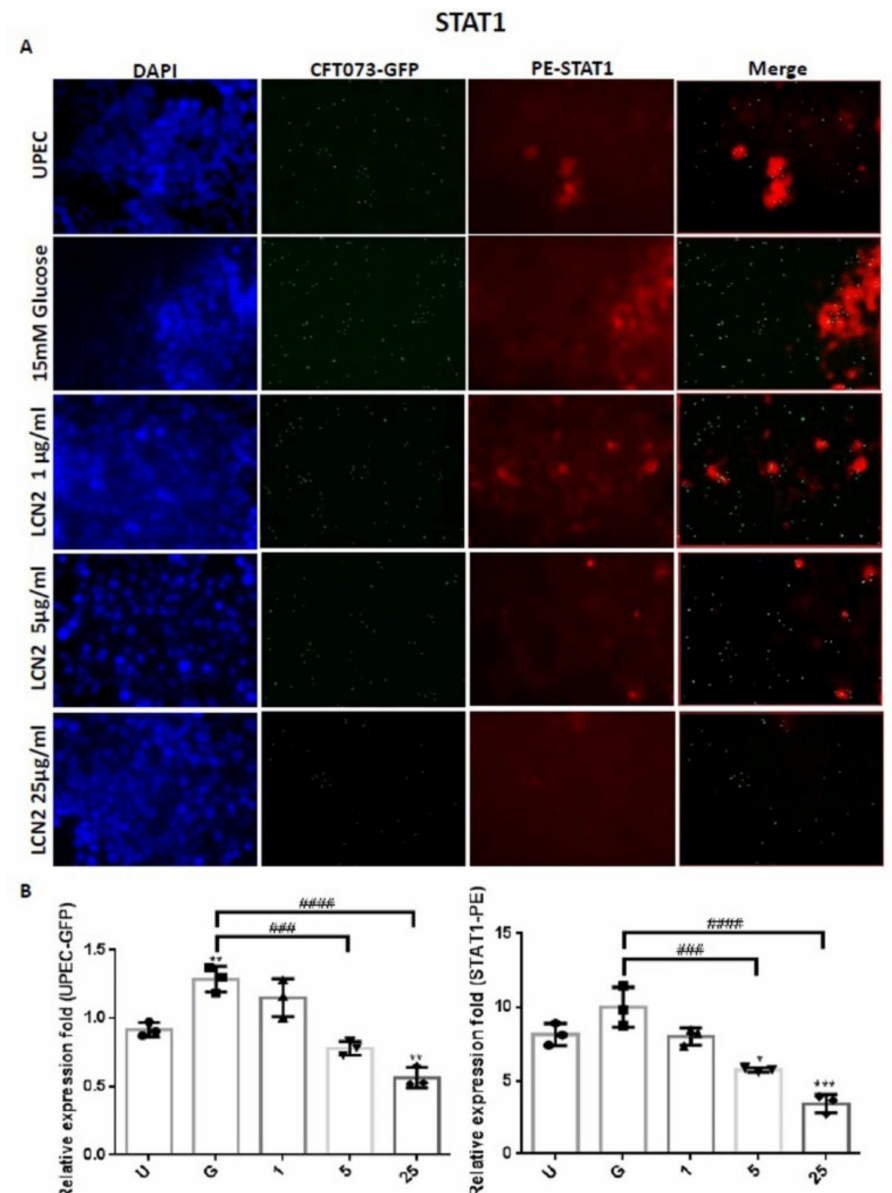
Figure 2. LCN2 decreased UPEC infections and STAT1 expression in bladder cells. SV-HUC-1 cells were first pretreated with 15 mM glucose, followed by treatment with different concentrations of LCN2 (1, 5, and 25 µ g/mL) for 24 h and infection with pGFP-UPEC (MOI of 1:100) for 4 h, as described in the text. The definitions of the letters on the X axis: U, UPEC infection alone; G, with 15 mM glucose pretreatment alone. GFP-UPEC and PE-STAT1 expression in SV-HUC-1 cells, for 4 h postinfection, were ( A ) observed by fluorescence microscopy and ( B ) measured using ImageJ software. Cells infected with UPEC alone were used as a positive control. The pictures shown are representative of typical results. DAPI was used to count the number of cells and as a standard for calculating the fluorescence expression ratios of cells. Cell images were captured using a microscope (Leica) at 100 × magnification. The data are expressed as means ± SDs from three separate experiments. An analysis of variance was used to evaluate differences between various treatment groups and controls. Statistical differences between groups were determined using the Mann–Whitney U Student’s t -test. Statistical significance was set at * p < 0.05. ** p < 0.01, *** p < 0.001 compared to the positive control groups. ### p < 0.001, #### p < 0.0001 for comparisons between two